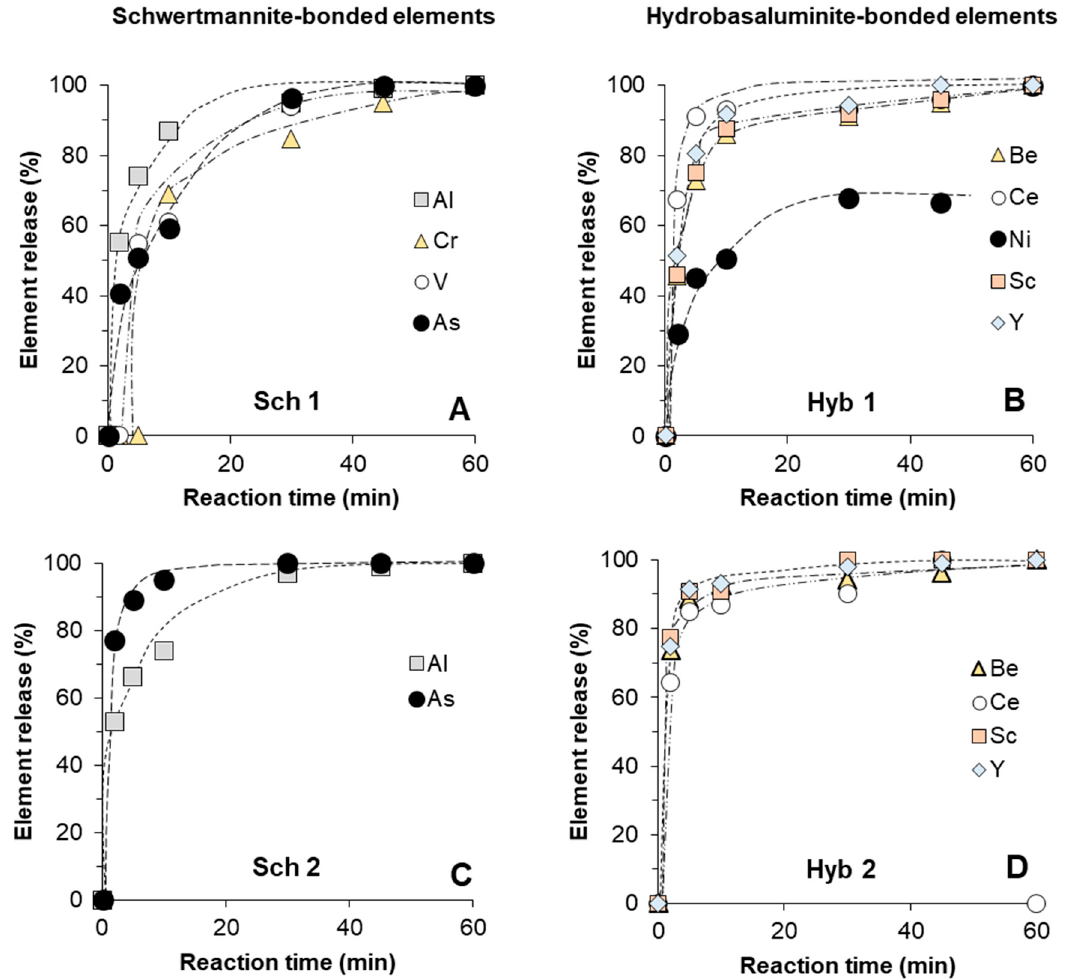
Figure 3. Leaching of different elements associated with schwertmannite (Al, Cr, V, As ( A – C )) or hydrobasaluminite (Be, Ce, Ni, Sc, Y ( B – D )) during dissolution in ammonium oxalate (pH 3.0). Element leaching is expressed as percentage with respect to their respective contents in the final solutions (Table 3).